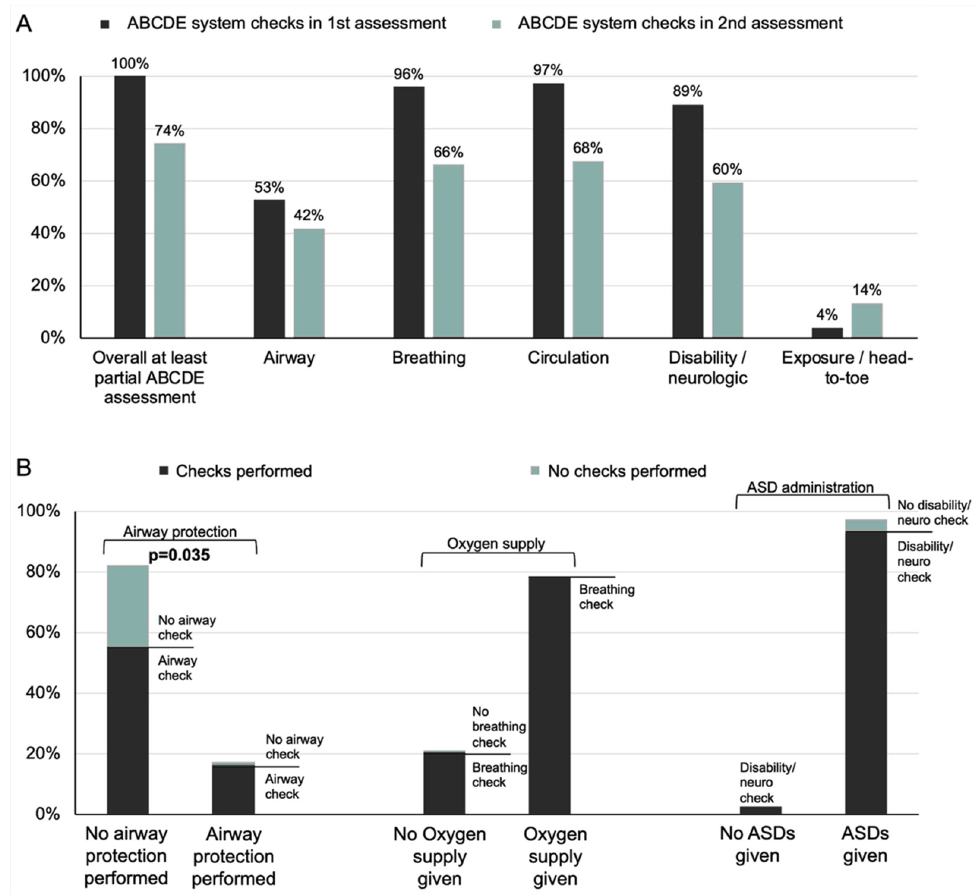
Figure 2. Executed ABCDE system checks ( A ) and deduced treatment measures ( B ) during management of a simulated status epilepticus. ASDs = antiseizure drugs.